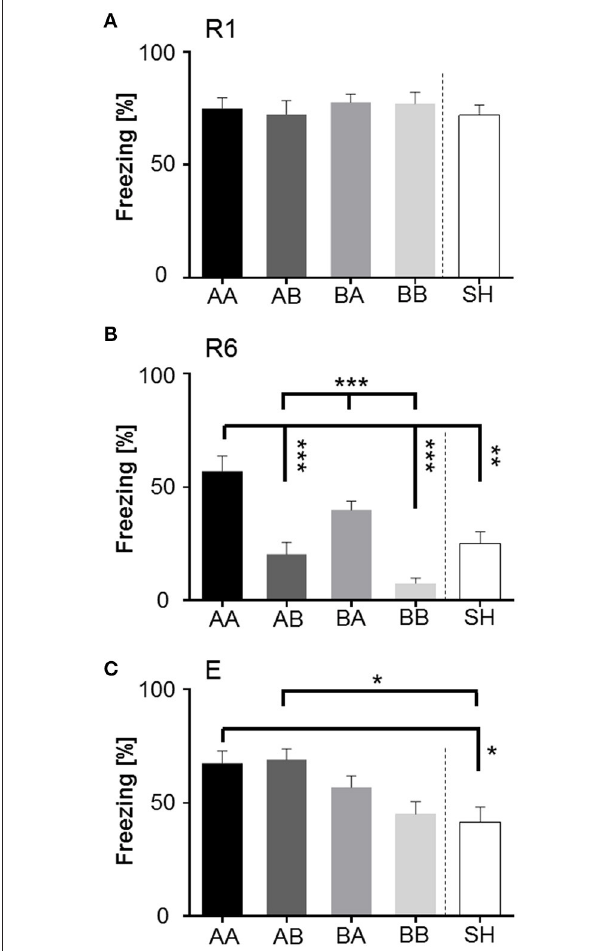
FIGURE 7 | Between-group comparison of freezing (% of time) in response to first CS + presentation during fear retrieval (R1), extinction (R6), and extinction recall (E). (A) R1: No significant differences were detected between groups, implying that all animals acquired conditioned fear memory to the same extent. (B) R6: Comparison between groups revealed that matched life history had the strongest diverging effect during fear extinction learning. Early and late adversity (AA) compromised extinction training, while early and late benefit (BB) significantly facilitated extinction learning. Animals experiencing late life adversity (BA) also showed significantly elevated freezing, whereas late life benefit (AB) as well as sham-handled mice (SH) showed moderate levels. (C) E: Mice subdued to early life adversity (AA and AB), were significantly negatively affected when tested for extinction memory consolidation in comparison to sham-handled mice. Animals of early life benefit showed moderate expression of freezing in response to CS + . * p < 0.05; ** p < 0.01; *** p < 0.001; animals per group: n =